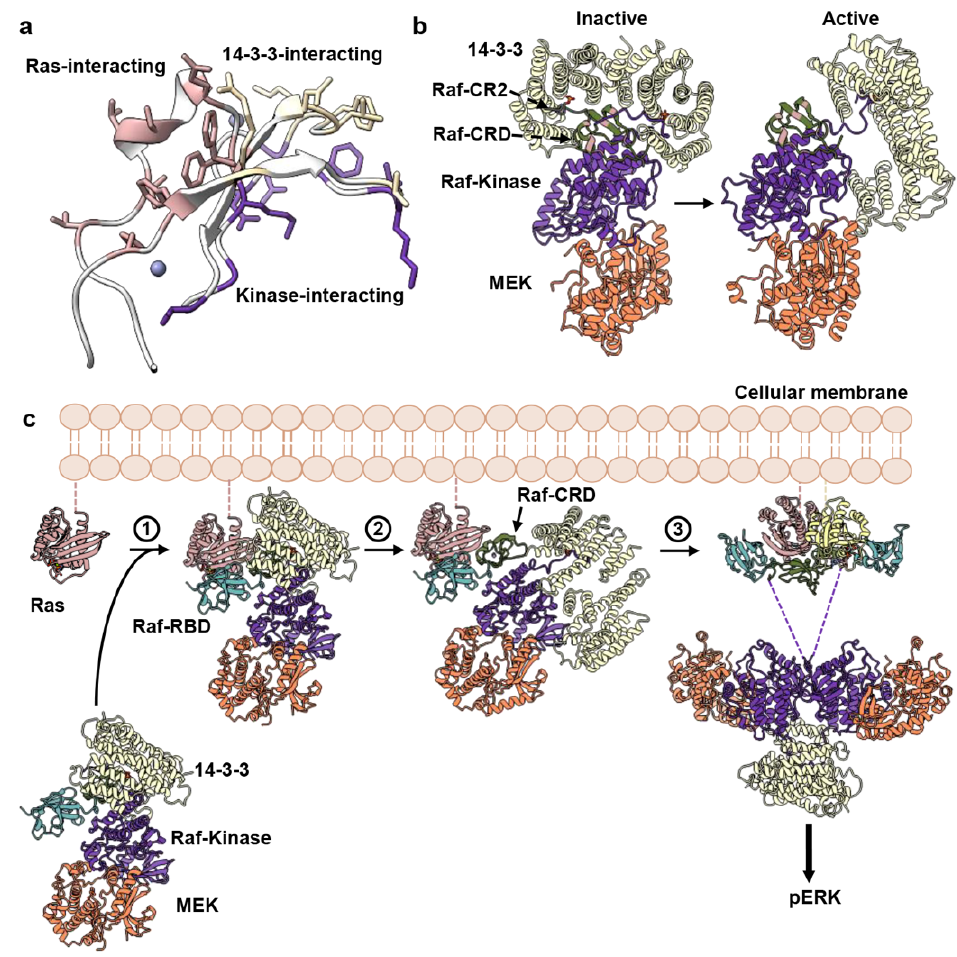
Figure 4. Proposed Mechanism for Ras-mediated activation of Raf. ( a ) Residues involved in the primary Ras–Raf-CRD interaction (pink) do not overlap with Raf-CRD residues used to stabilize contacts with the kinase domain (purple) and 14-3-3 proteins (wheat) in the autoinhibited state. ( b ) Comparison of Raf-kinase domain (purple) and 14-3-3 (wheat) conformations in the inactive (PDB ID 6NYB) and active Raf structure (PDB ID 6Q0J). Note the shift in the 14-3-3 dimer in the absence of the Raf CR2 motif and release of the Raf-CRD. ( c ) Proposed structural model for the Ras-mediated release of Raf autoinhibition and activation of MAPK signaling. Raf-RBD (cyan) is exposed in the autoinhibited state, disordered in the cryo-EM structure, likely due to flexibility in its linker to the CRD (dark green). The high-affinity binding of Raf-RBD to Ras places the exposed area of the CRD in its Ras-binding site, while steric hindrance is expected to displace the Raf C-terminus (purple) and promote the shift of the 14-3-3 dimer (wheat) towards its active state interaction with a second Raf kinase domain (purple). These two features of the Ras–Raf interaction are shown in steps 1 and 2. Binding of Raf-RBD concurrently promotes dimerization of the complex as shown in step 3, which we propose is a key step in binding Galectin dimers to build a platform for signal amplification (see Figure 3e). We propose that steps 1, 2 and 3 occur concertedly to activate Raf.